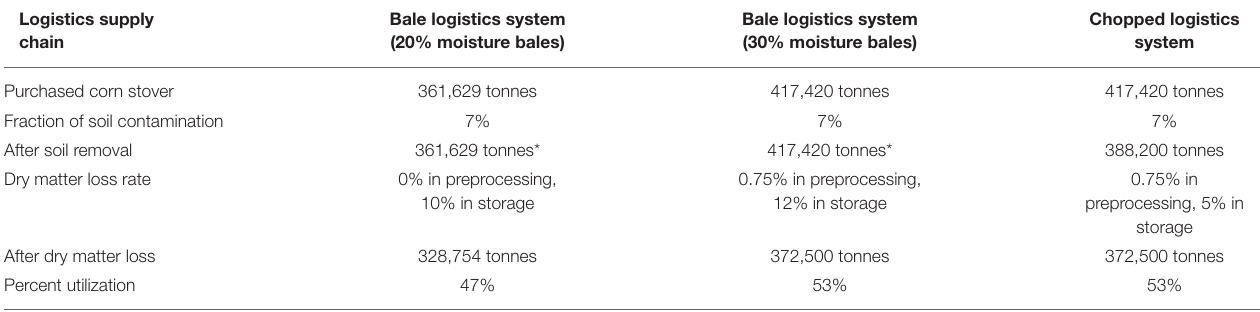
TABLE 1 | Annual tonnages required to supply a biorefinery with 2,000 dry tonnes corn stover per